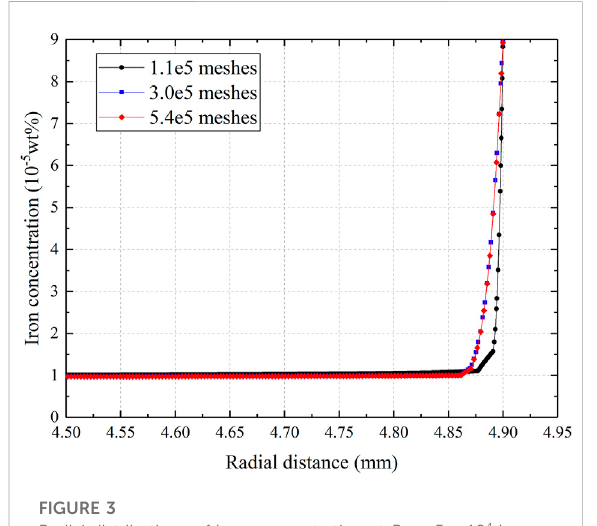
FIGURE 3 Radial distributions of iron concentration at Re = 5 × 10 4 in mesh independent check.